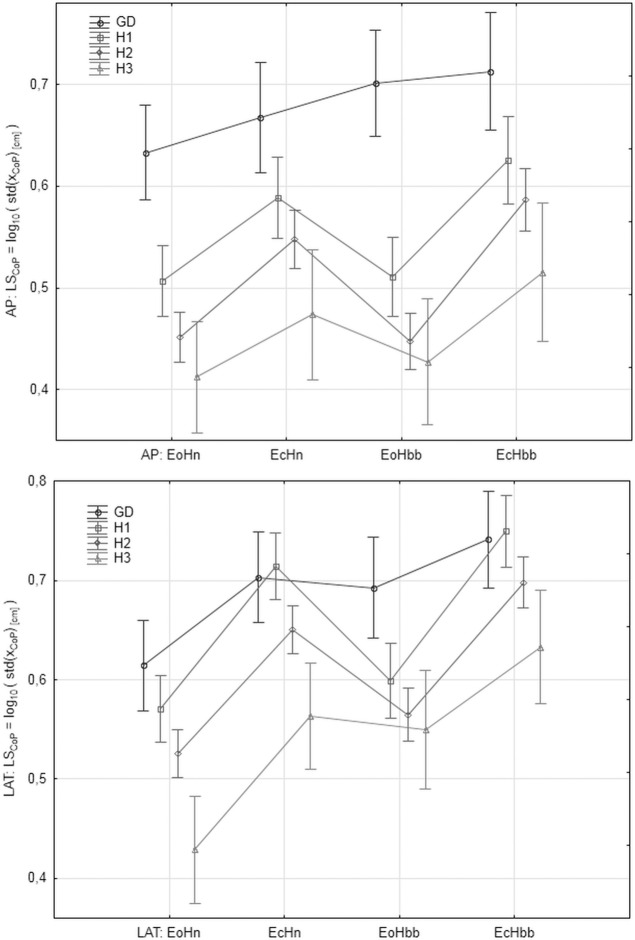
The mean values of LSCoP = log10(SCoP) in the subsequent patients and registration condition groups.SCoP represents the variability of xCoP signal measured as SCoP = std (xCoP). Upper: antero-posterior (AP), bottom: lateral (LAT) component of the signal.